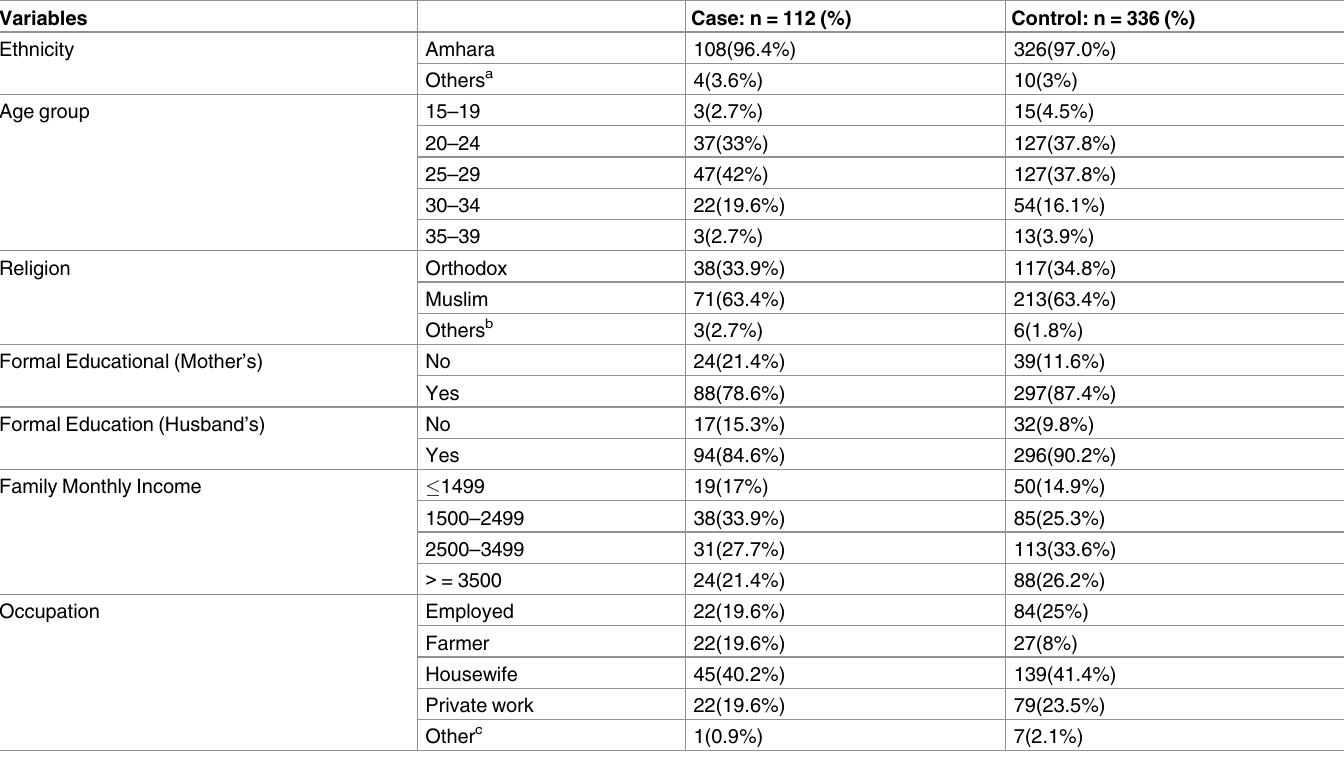
Table 1. Socio-demographic and economic characteristics of pregnant mother attending ANC in health facilities of Dessie town, from January to March 2016